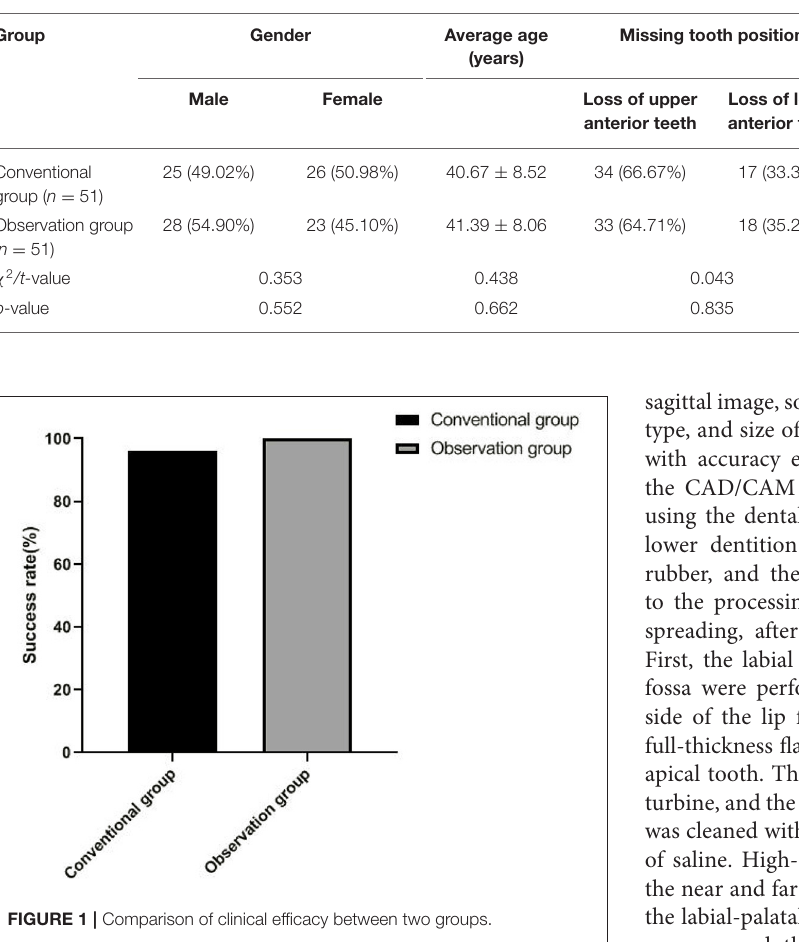
bone width and bone height at the missing tooth, and adjacent to important anatomical